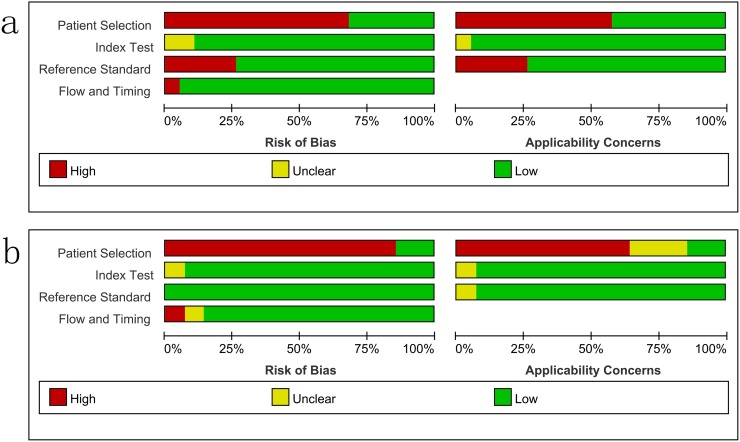
Methodological quality graphs (risk of bias and applicability concerns) as percentages across the included studies.a: composite reference standard. b: culture reference standard.